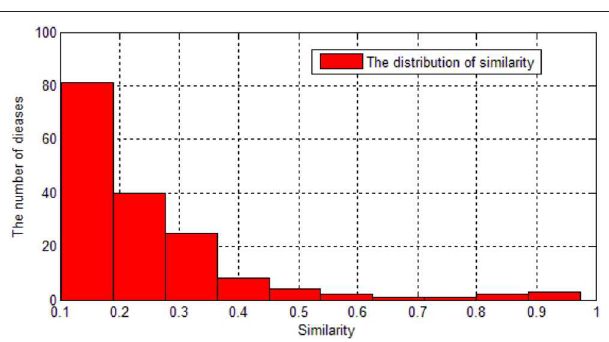
FIGURE 2 | The distribution of